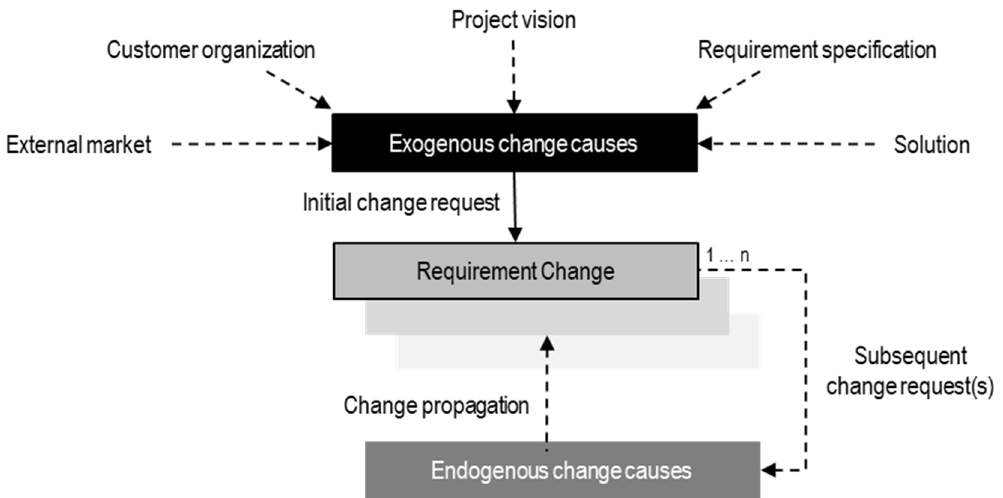
Figure 2. Overview of exogenous and endogenous change causes .